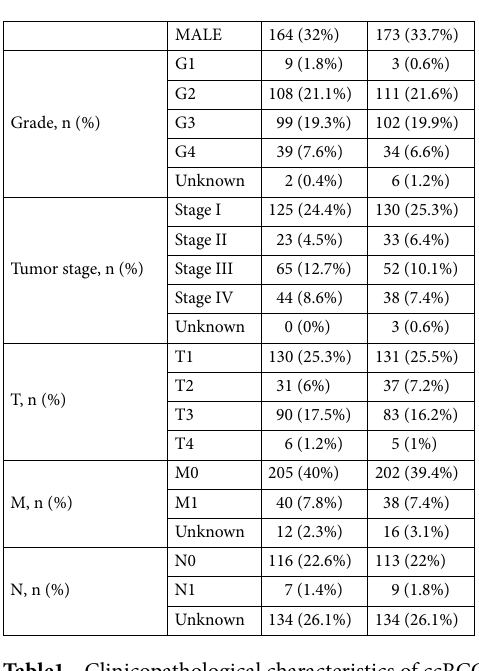
Table1. Clinicopathological characteristics of ccRCC patients.